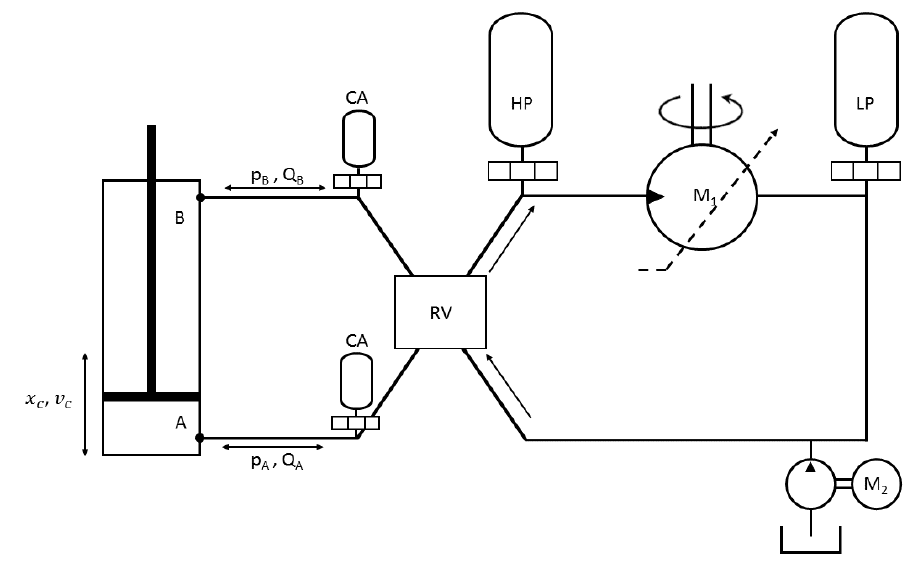
Figure 6. Generic hydraulic transmission